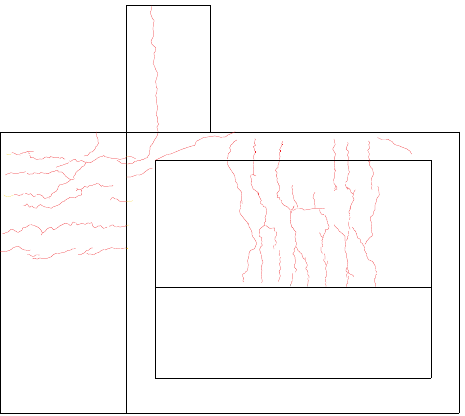
Figure 6. Crack distribution of ordinary specimen.